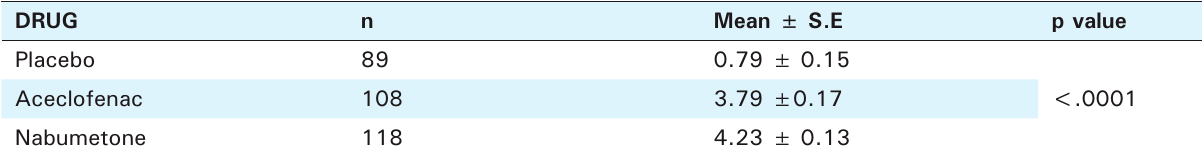
Table 3. Effect of treatment of osteoarthritis with placebo, 100 mg aceclofenac (twice daily) and 750 mg nabumetone (twice daily) after 4 weeks